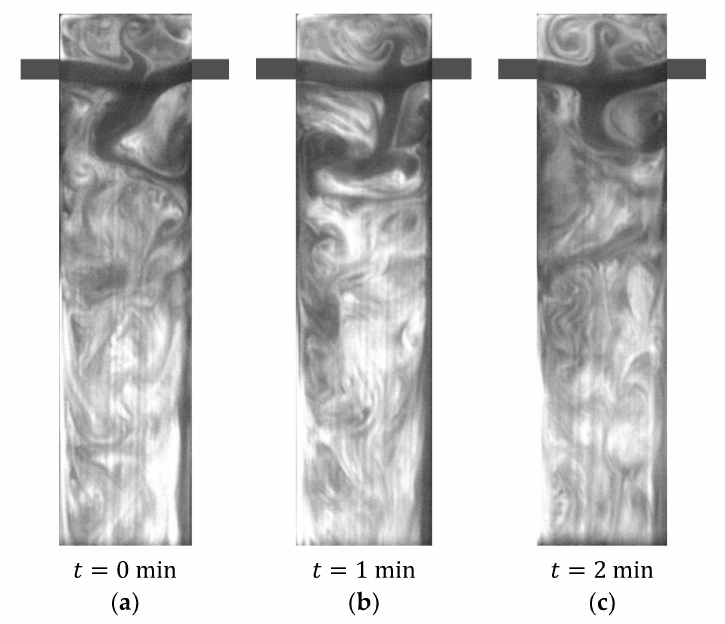
Figure 8. PLIF image obtained with AB-RPLIF at Re =